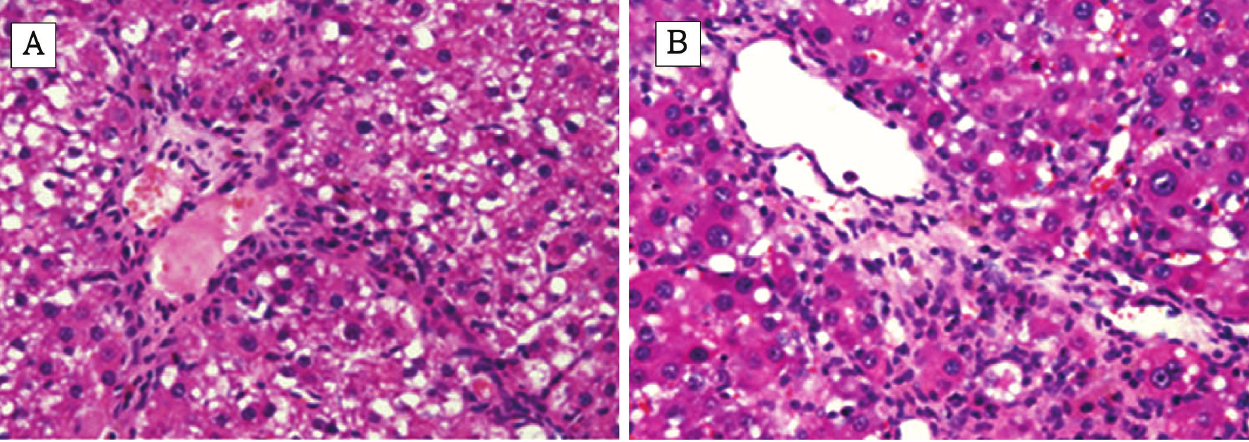
FIGURE 2 - Pictures showing the histopathological images of livers from different experimental groups (A)TAA group-showing marked vacuolar degeneration and fibrosis (B)TAA+LES group-showing mild vacuolation. Hematoxylin-Eosin stain. Magnification